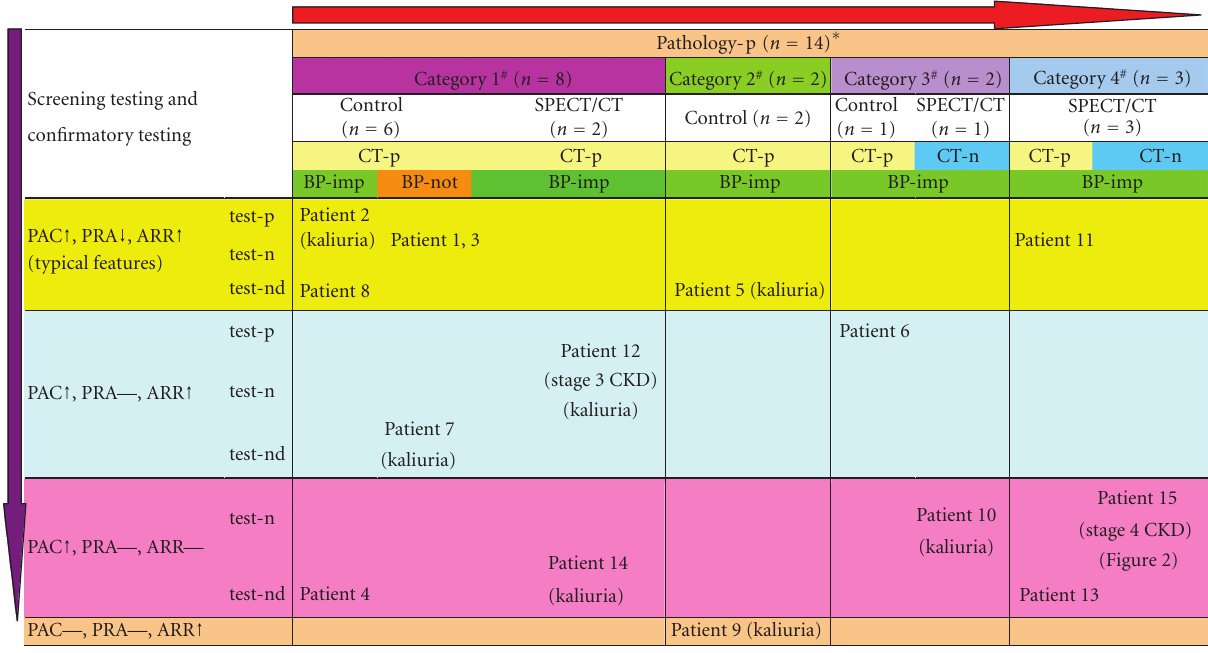
Figure 1: Qualitative analysis of Tables 1 and